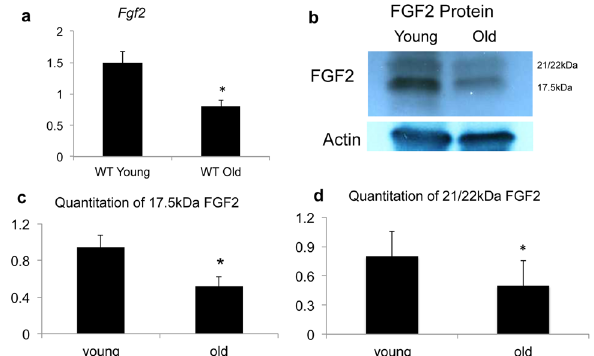
Figure 3. FGF2 expression in skeletal muscle of young and old WT muscle. Young (2 months) and old (18 months) WT mouse hindlimb muscles were isolated and qPCR and Western blotting for Fgf2 mRNA and FGF2 protein were performed on whole muscle isolates. ( a ) Fgf2 mRNA relative to actin. n = 6–10 mice/group. ( b ) Representative Western blots for FGF2 protein and ( c ) quantitative analysis of 17.5 kDa FGF2 isoform.